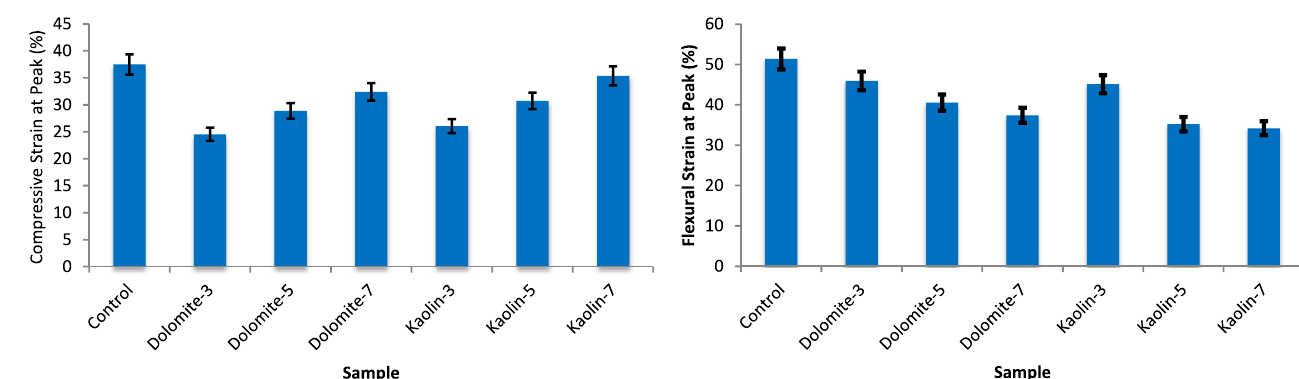
Fig. 9. Flexural strain at peak of the dolomite and kaoline fi lled polyurethane foam.